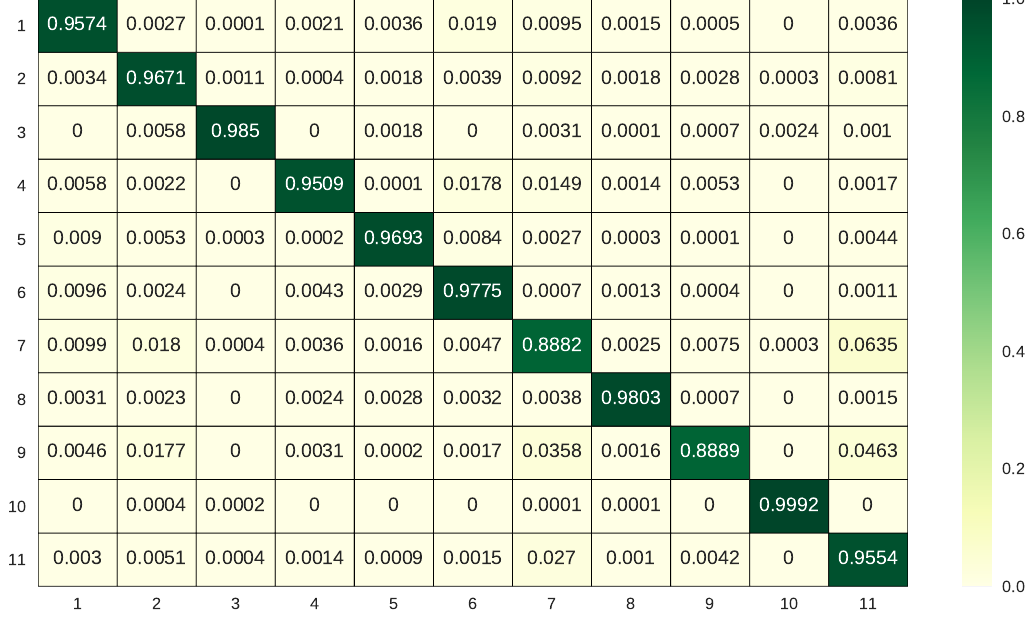
Figure 14. Classification confusion matrix for Flevoland data set by usingBSLGDA + FCN.